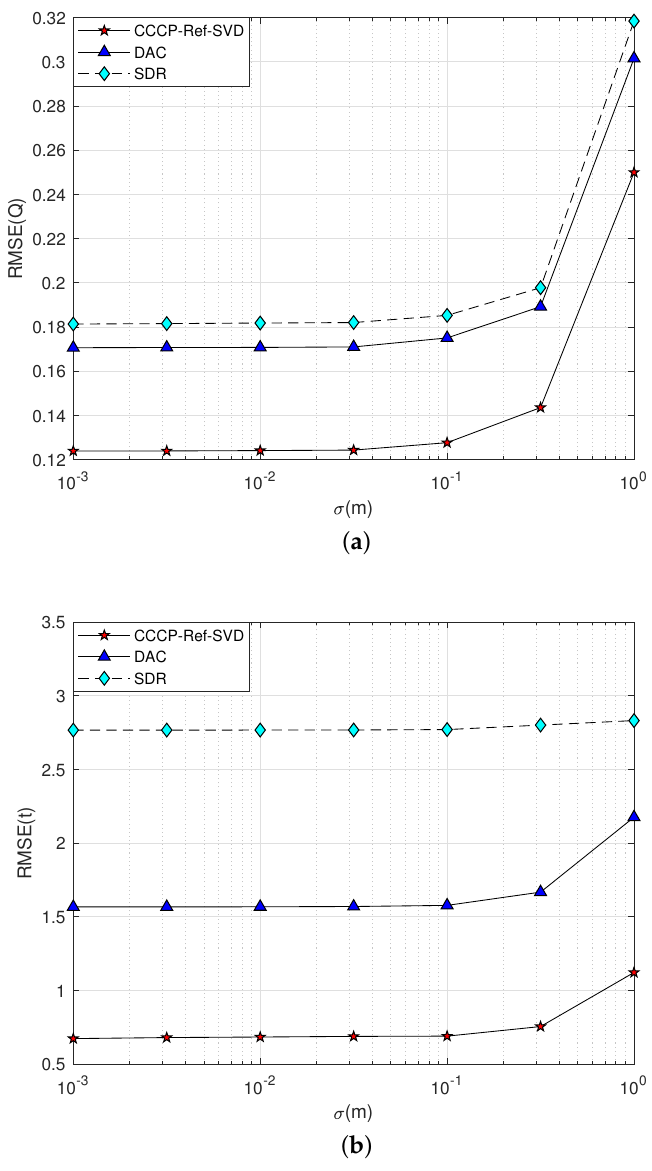
Figure 5. Performance curve of rigid body’s posture parameter estimation with measurement noise σ mi increasing in 3–D scenario. ( a ) Q Estimation; ( b ) t